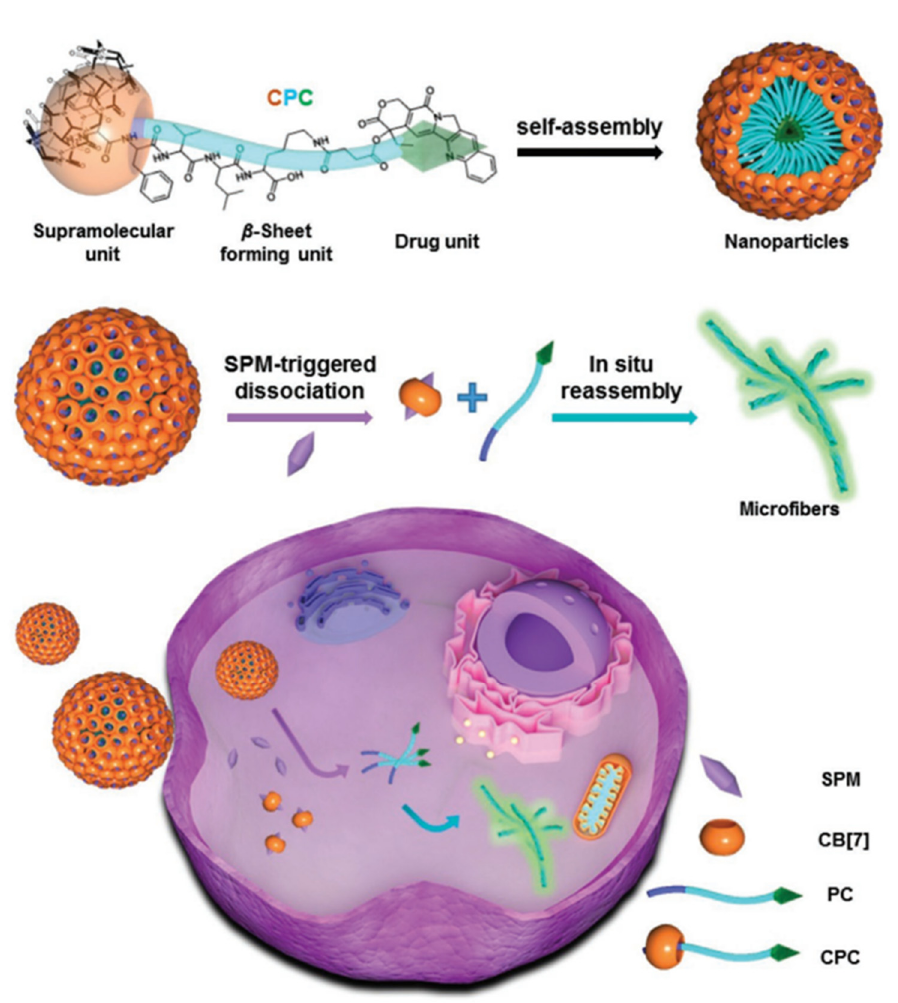
Figure 20. Schematic diagram of CPC drug synthesis and mechanism of function (reproduced with permission of John Wiley & Sons, Inc. from ref. [96]). permission of John Wiley & Sons, Inc. from ref.